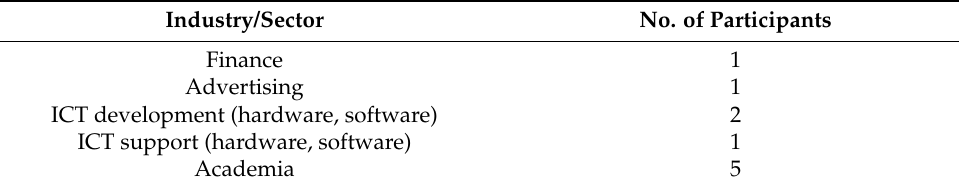
Table 2. Participants by